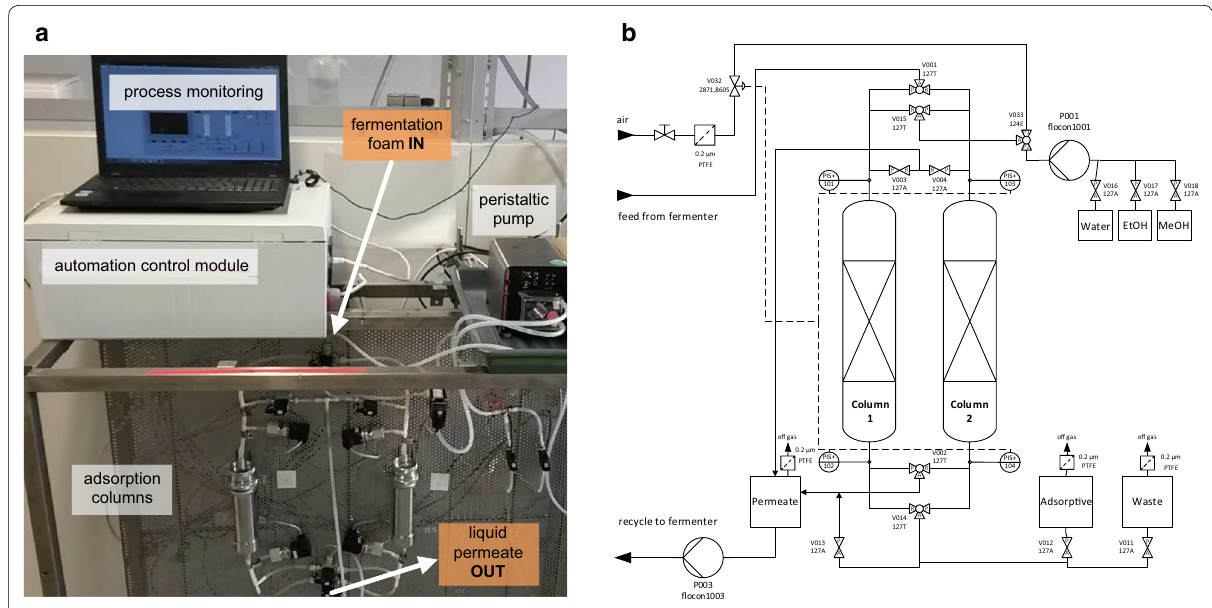
Fig. 2 Laboratory setup ( a ) and process flow sheet ( b ) of automated adsorption unit. Adsorption columns were used alternatively, where adsorption phase was set to 12 h. In non-adsorptive column mode, elution and preparation for the next run were